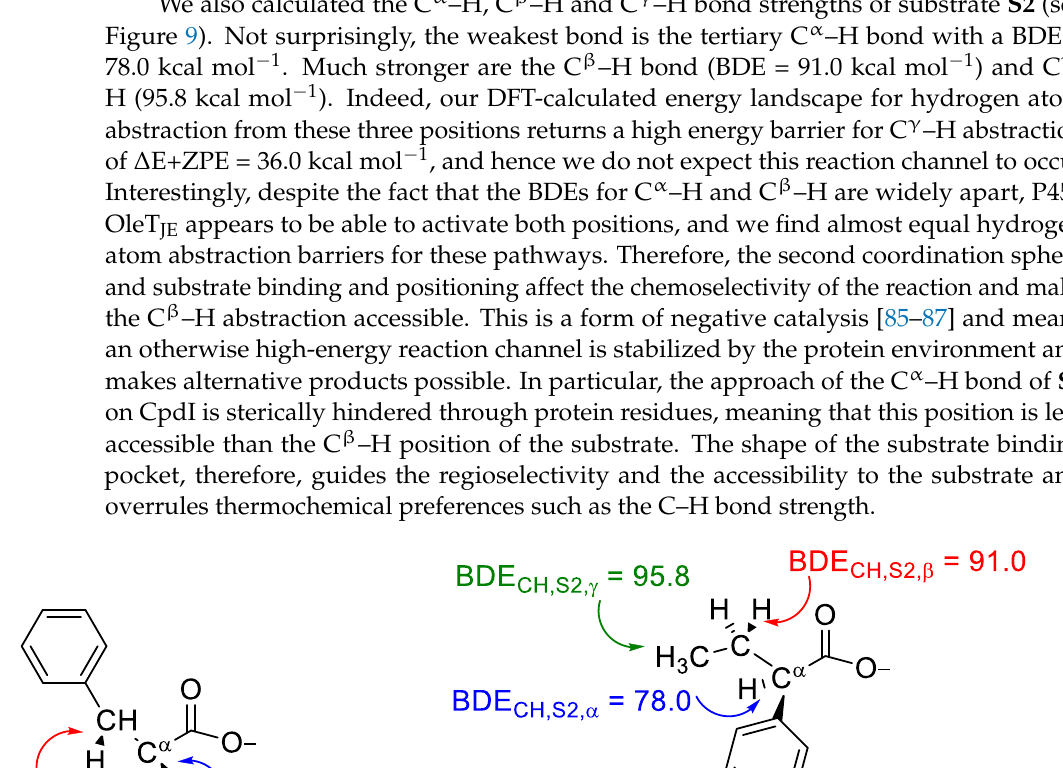
Figure 9. Calculated substrate BDE values for selected C − H bonds in S1 and S2 . Values are E+ZPE in kcal mol − 1 .